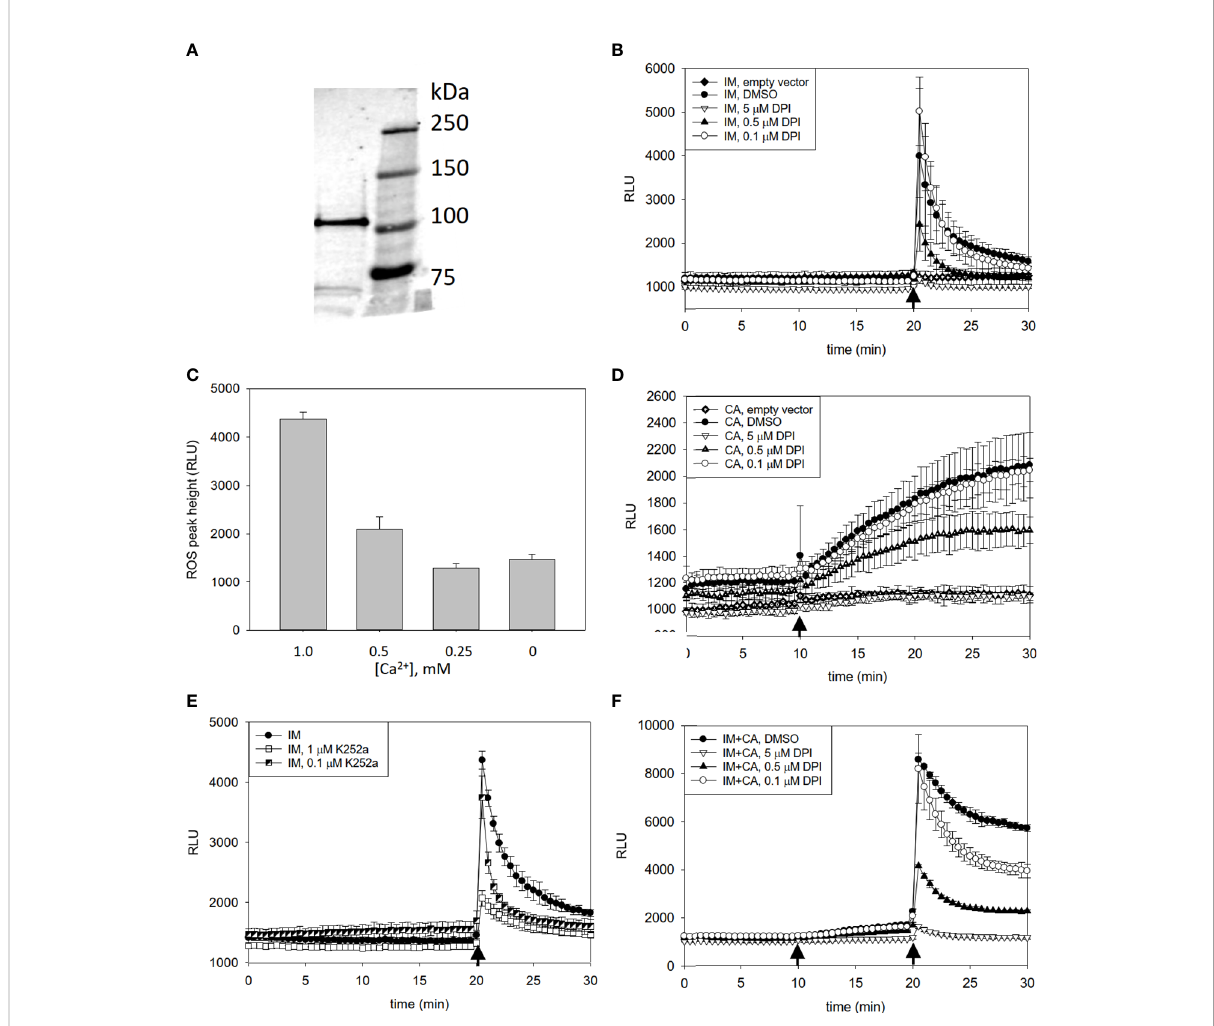
FIGURE 3 Detection of heterologously produced PaRBOH1 in HEK cells and effects of pharmacological inhibitors and Ca 2+ on ROS production. (A) A protein of a correct size (107 kDa) is produced in HEK cells transfected with a PaRBOH1 construct as revealed by a Western blot using an antibody against the FLAG-tag. (B – F) Effects of pharmacological inhibitors and Ca 2+ on ROS production in human embryogenic kidney (HEK293T) cells transfected with PaRBOH1. (B) After measuring the baseline ROS production for 20 min, a Ca 2+ ionophore ionomycin (IM; 1 µM) and 1 mM Ca 2+ were simultaneously injected into the assay mixture. (C) Various concentrations of Ca 2+ were externally added to assay wells just prior to the start of the experiment. IM was injected at 20 min. Maximum ROS peaks are shown. (D) After measuring the baseline ROS production for 10 min, a phosphatase inhibitor calyculin A (CA; 0.1 µM) was injected into the assay mixture. (E) Effect of a kinase inhibitor K252a on ROS production. K252a (0.1 or 1 µM) was supplemented to the assay mixture just prior to the start of an experiment. IM was injected at 20 min. (F) A combined effect of calyculin A and IM on ROS production. Calyculin A (0.1 µM) was injected at 10 min, and IM (1 µM) supplemented with 1 mM Ca 2+ at 20 min. In Figure 3 (B, D, F) , an inhibitor of fl avin-containing enzymes, diphenylene iodonium (DPI, 0.1, 0.5 or 5 µM), was supplemented to the assay mixture just prior to the start of an experiment. Control wells obtained a corresponding volume of DMSO. Data are expressed as relative luminescence units (RLU). Each data point represents the average of three wells analyzed in parallel (mean ± S.D.). The experiment was repeated for at least three times in separate experiments with similar trend in results. Arrows, time of